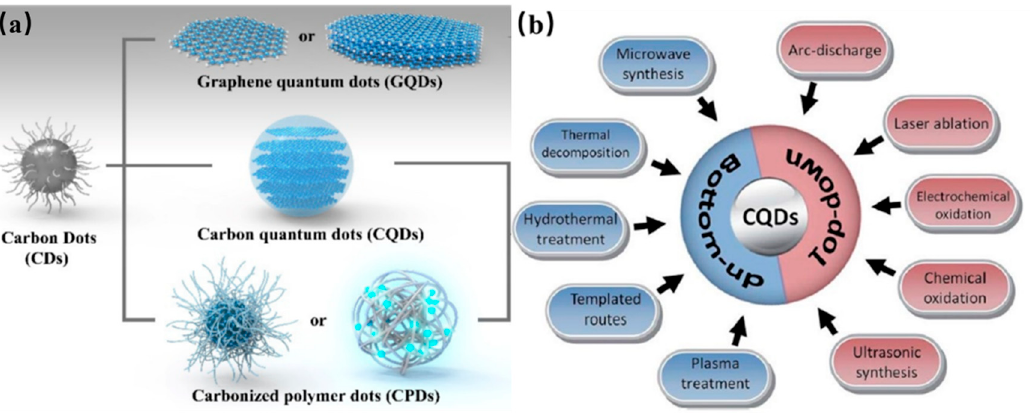
Figure 1. ( a ) Carbon dots including graphene quantum dots, carbon nanodots and polymer dots [28]. Copyright 2020, American Chemical Society. ( b ) Carbon dots synthesized from “top-down” and “bottom-up” approaches [29]. Copyright 2017, Royal Society of Chemistry.